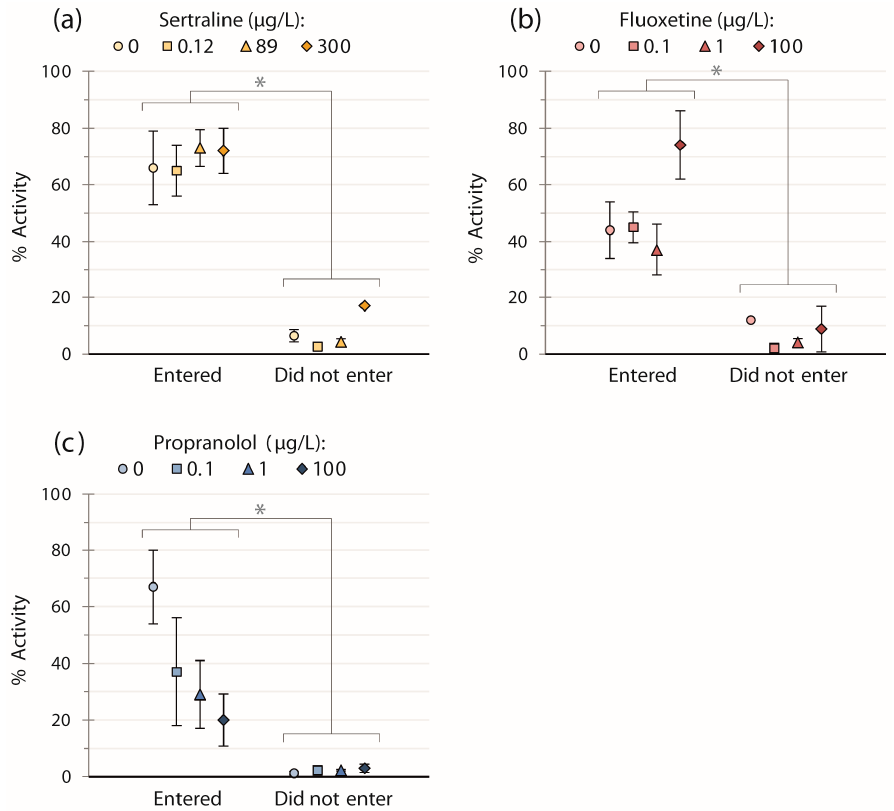
Figure 1. Means ± SEM of the general swimming activity of fish exposed to: ( a ) sertraline ( n = 39); ( b ) fluoxetine ( n = 40); or ( c ) propranolol ( n = 39), for fish that entered and did not enter the strike zone. Fish entering the strike zone displayed higher activity versus those which did not ( p < 0.001 for all three pharmaceuticals, regardless of concentration). There were no significant effects of pharmaceutical concentration within the two groups.